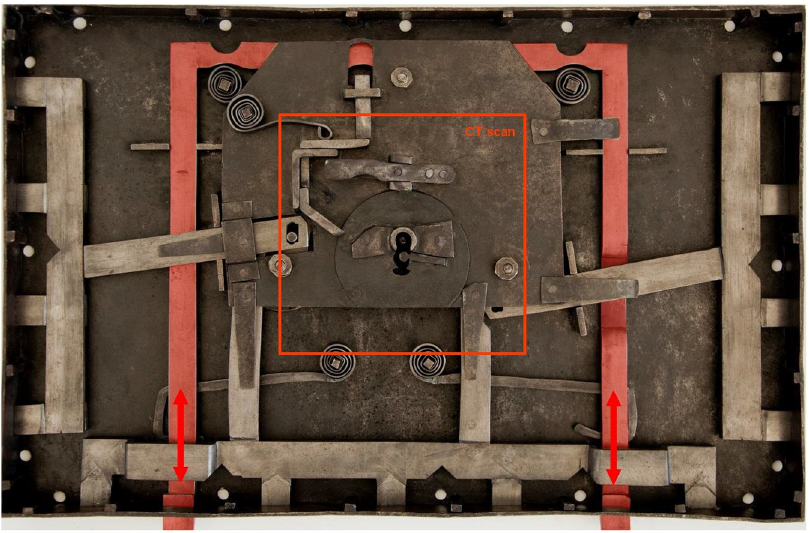
Fig 4. Complete lock mechanism of the chest in the case from below the covering plate (after restoration) [27] including the bolts and levers of the first mechanism; the lever of the second mechanism with the bolts in a locked position is marked red with the direction of their motion indicated by the